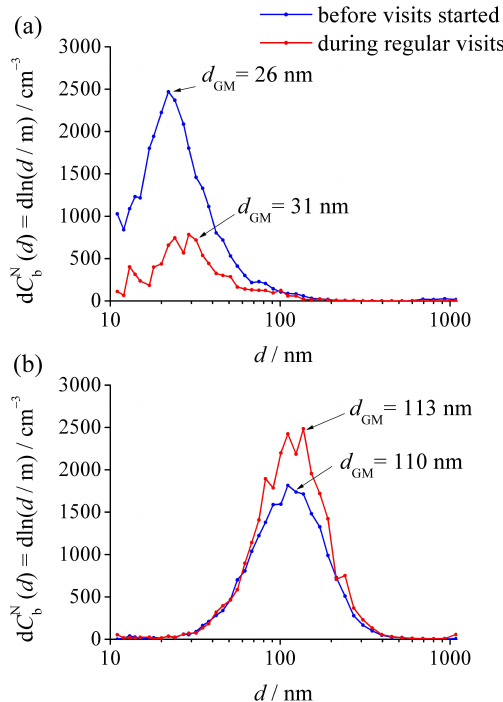
(d) = d ln (d/m) ) of background b